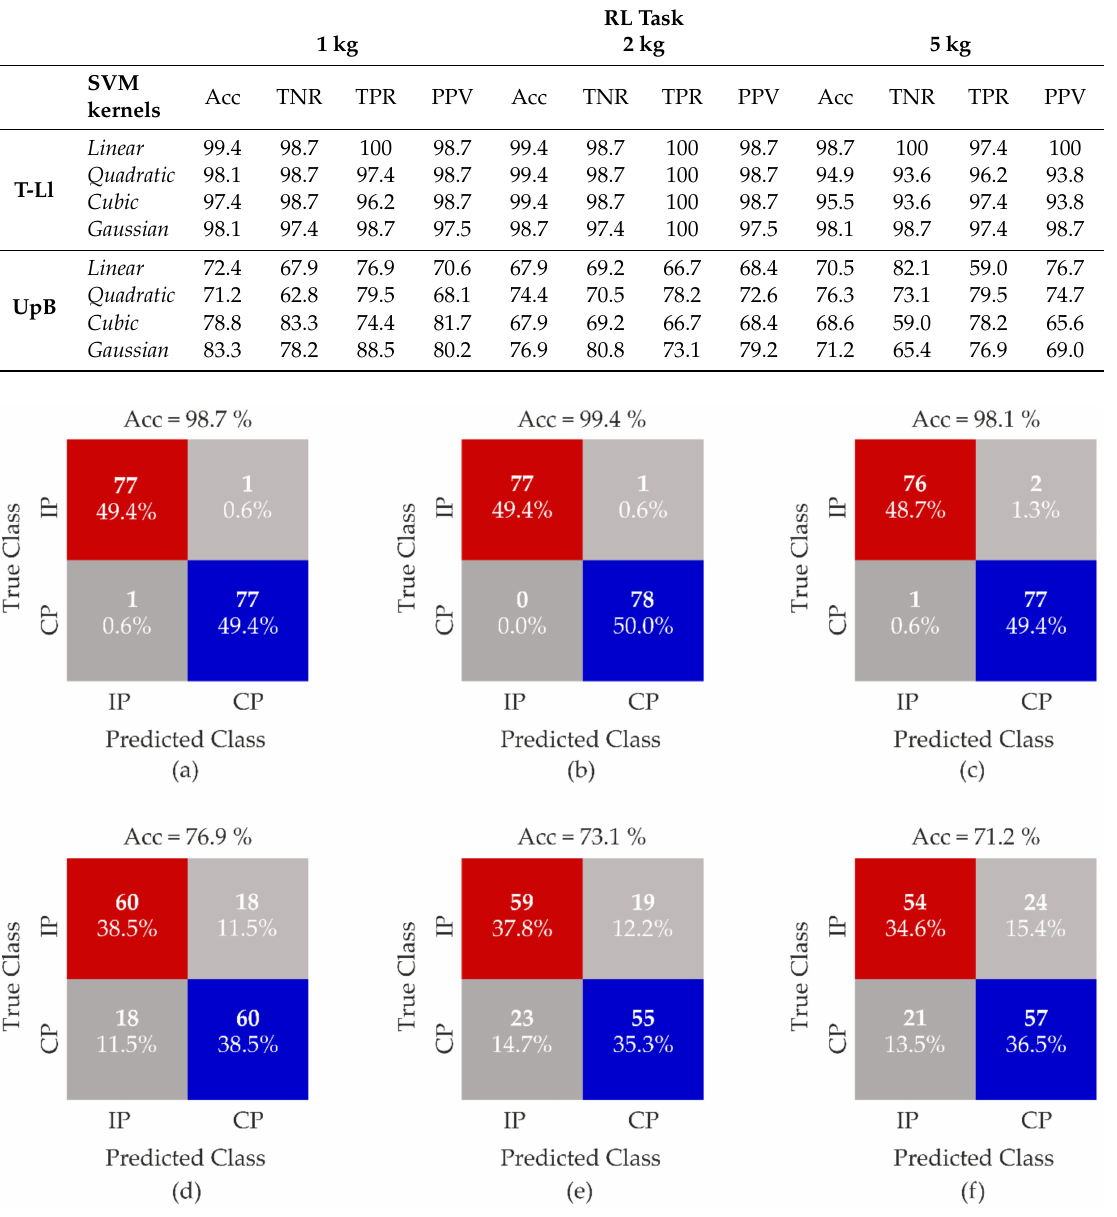
Table 4. Overall accuracy (Acc), specificity (true negative rate (TNR)), sensitivity / recall (true positive rate (TPR)) and precision (positive predictive value (PPV)) values of the posture recognition when using the four di ff erent kernel functions considering the trunk–lower limb (T-Ll) and upper body (UpB) datasets in the RL task.